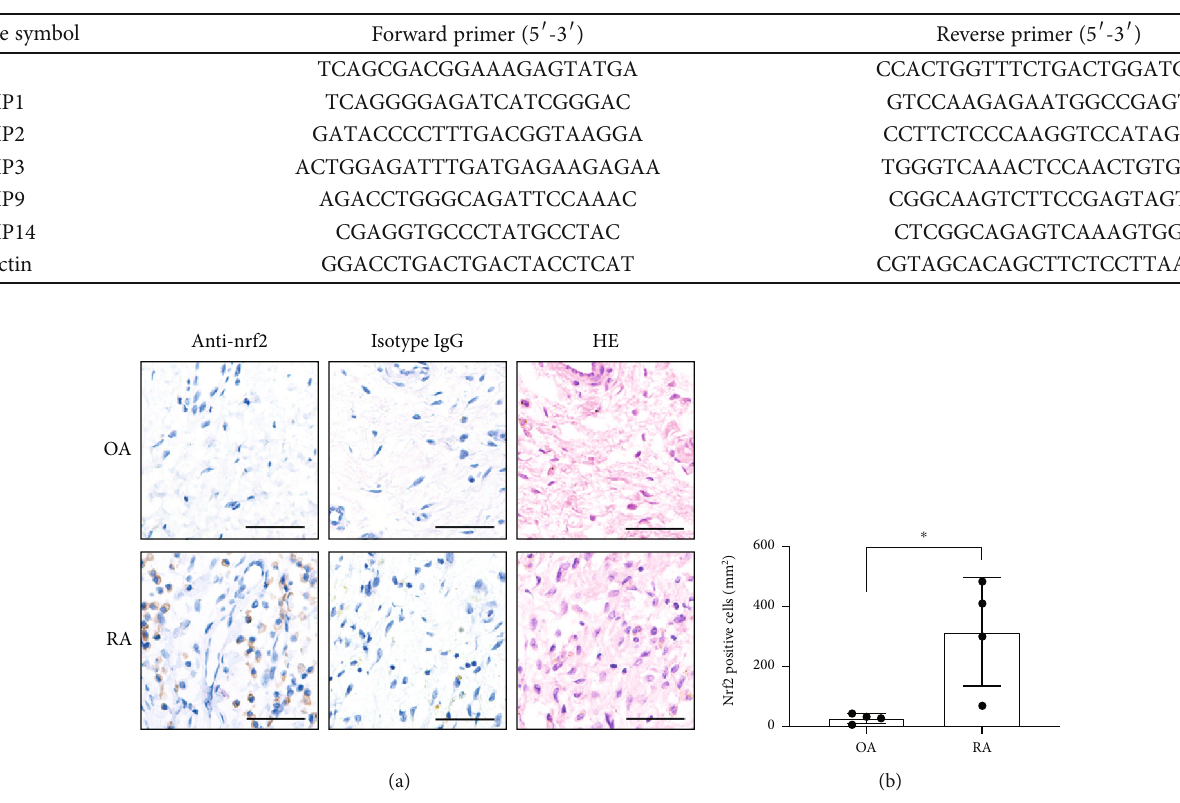
Figure 1: Nuclear factor erythroid 2-related factor 2 (nrf2) expression in rheumatoid arthritis (RA) and osteoarthritis (OA). (a) Immunohistochemistry staining using anti-nrf2 antibodies and rabbit IgG (isotype) and hematoxylin and eosin (HE) staining of RA and OA synovial tissues. (b) Nrf2-positive cell densities in the synovial tissues of RA and OA. Scale bars represented 50 μ m. N = 4 . Data were shown as the mean ± standard deviation (SD); ∗ p < 0 : 05